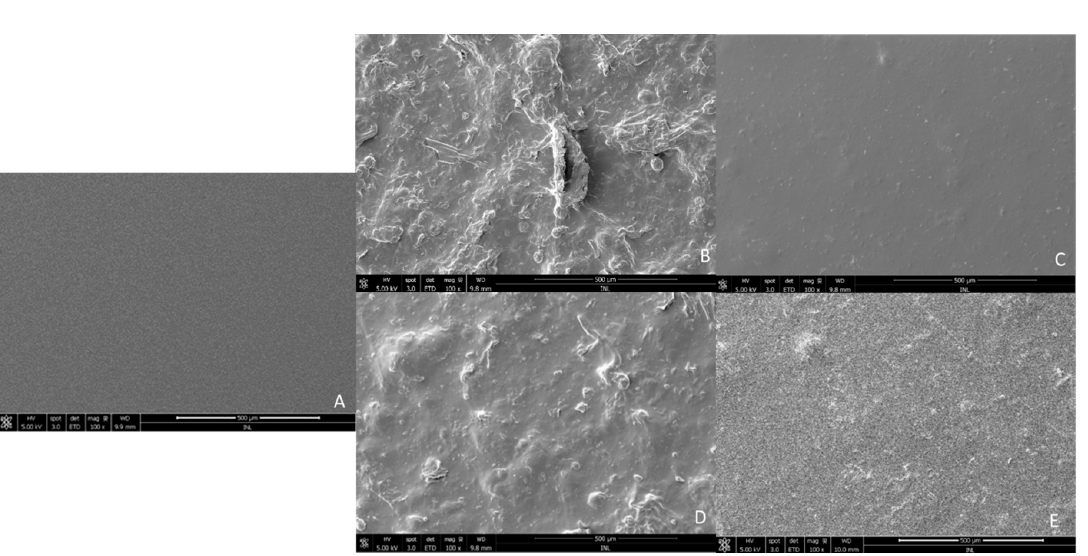
Figure 2. Scanning electron microscopy (SEM) images of surfaces of the edible films. ( A ) Control, ( B ) Copena F1 without fibre (Copwtf), ( C ) Copena F1 with fibre (Copwf), ( D ) Villanueva without fibre (Viwtf) and ( E ) Villanueva with fibre (Viwf) (100× magnification) (scale bar corresponds to 500 µm).